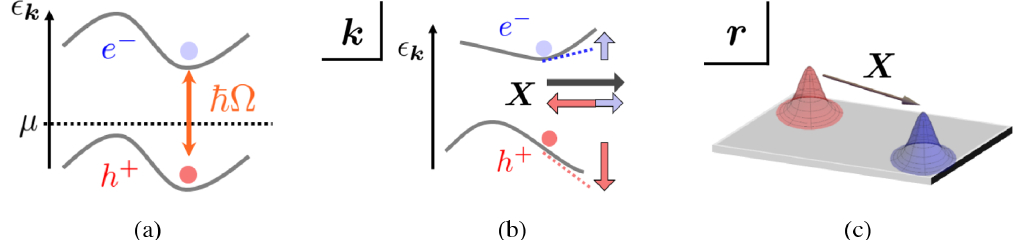
FIG. 1. Schematic picture of the two processes causing the photocurrent response. (a) Electron-hole pair creation and (b,c) alternating rectification of paired charges by the director. There are two kinds of directors: (b) the group velocity difference for the injection currents (momentum space picture) and (c) the positional shift of wave packets for the shift and gyration currents (real space